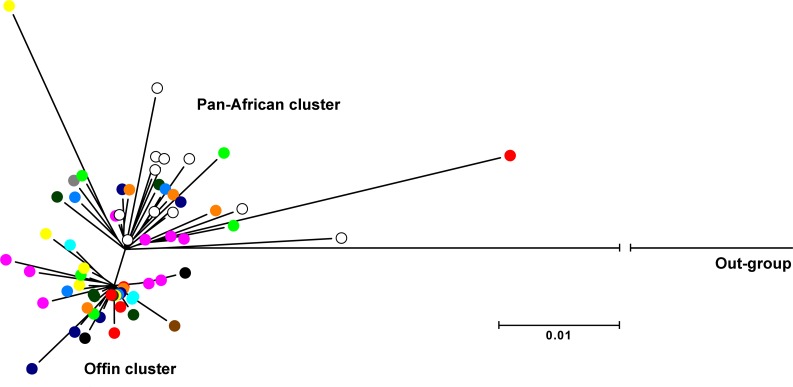
Phylogenetic reconstruction of HBV/E sequences.A maximum-likelihood phylogenetic tree based on the pre-S/S gene region sequence (1,200 bp) was constructed using the Kimura 2-parameter +G model [41] embedded in MEGA6 [42]. While HBV sequences obtained in this study are indicated as multicolored dots (according to village of residence), HBV genotype E sequences retrieved from GenBank are depicted as empty circles (accession numbers (origin): AB205192 (Ghana), AB106564 (Ghana), DQ060830 (Madagascar), AB201290 (Benin), AB205188 (Ghana), AB091255 (Côte d'Ivoire) AB091256 (Côte d'Ivoire), HM363611 (Nigeria), FN594765 (Niger), AB205191 (Ghana), AB205190 (Ghana)). The sequence of the genotype D AY233291 from South Africa was included as an out-group.